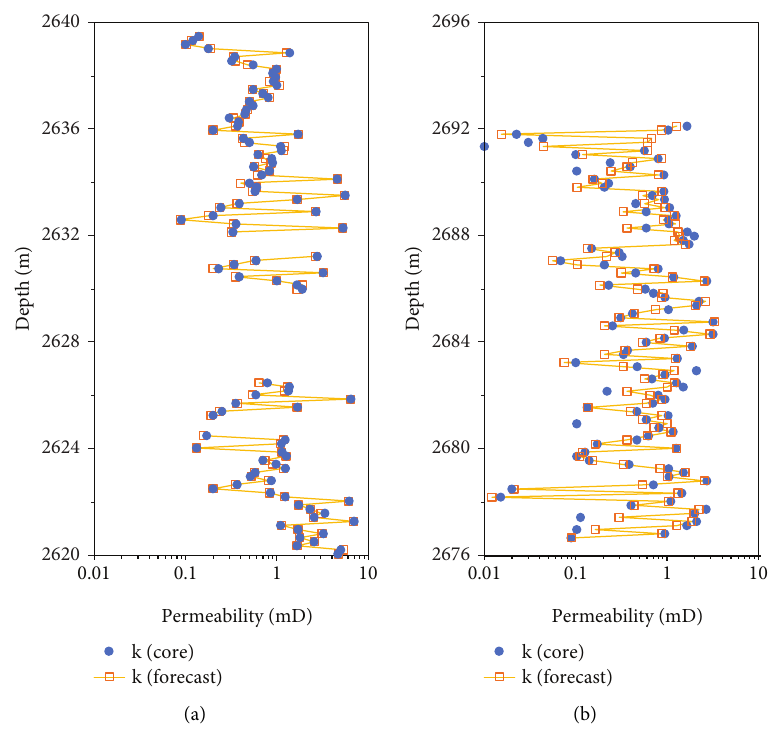
Figure 10: Profile of permeability prediction. (a) Well D52. (b) Well